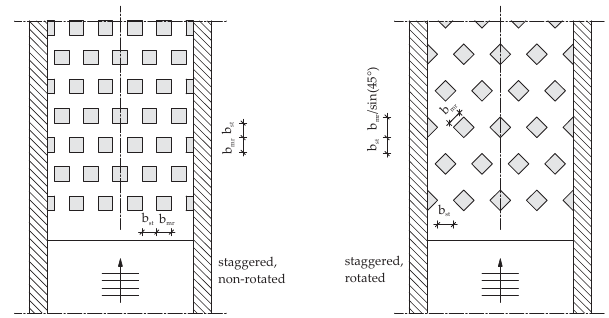
Fig. 4. Symmetry requirements for the configuration of the MR el- ements for a staggered, non-rotated configuration (left) and a stag- gered rotated configuration (right), drawing not to scale, demonstra- tion of the axis of symmetry at the flume wall, which always cuts an MR element in the half.